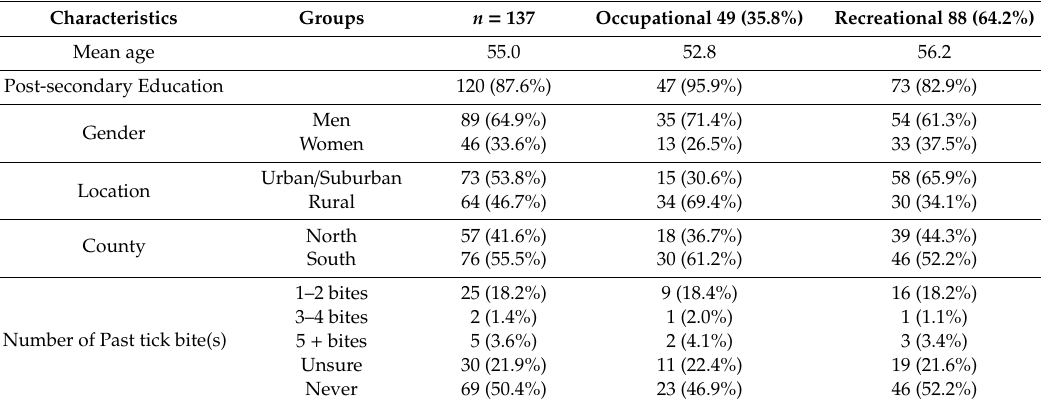
Table 1. Demographic characteristics and tick exposure of the